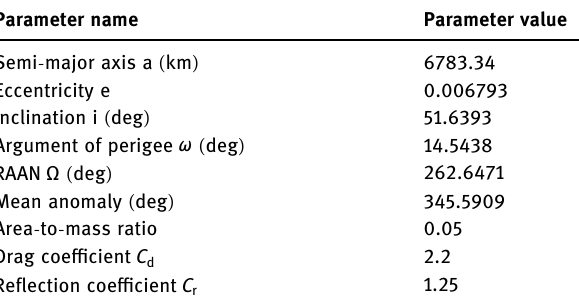
Table 3: Parameters of simulated